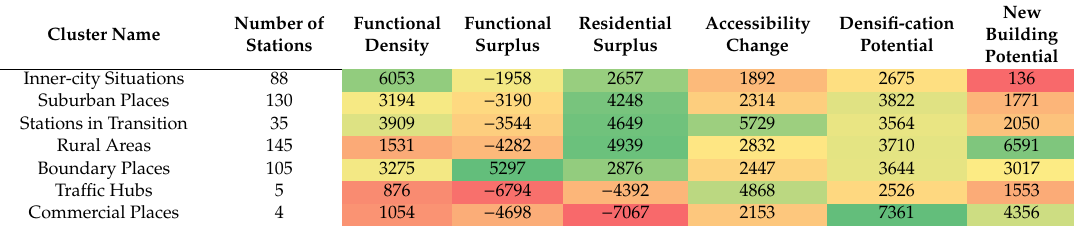
Table 2. Average values of the clustering variables for the seven clusters of